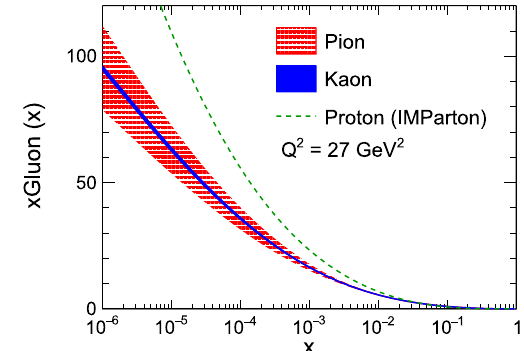
Fig. 11 The comparisons of the gluon distributions inside the pion, the kaon, and the proton at Q 2 = 27 GeV 2 . The error bands of this work show the 3 σ uncertainties of the quantities